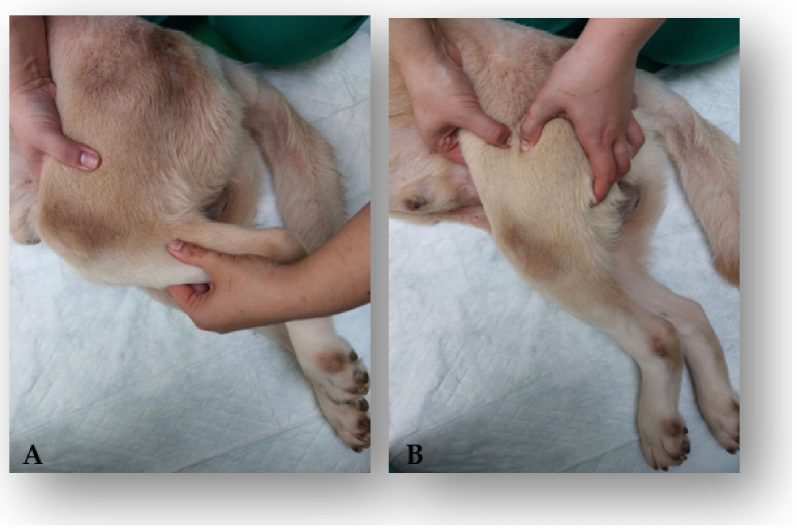
Figure 8. Supportive treatment. ( A ) Passive range of motion exercises for the knee joint; ( B ) deep kneading massage technique for direct muscular